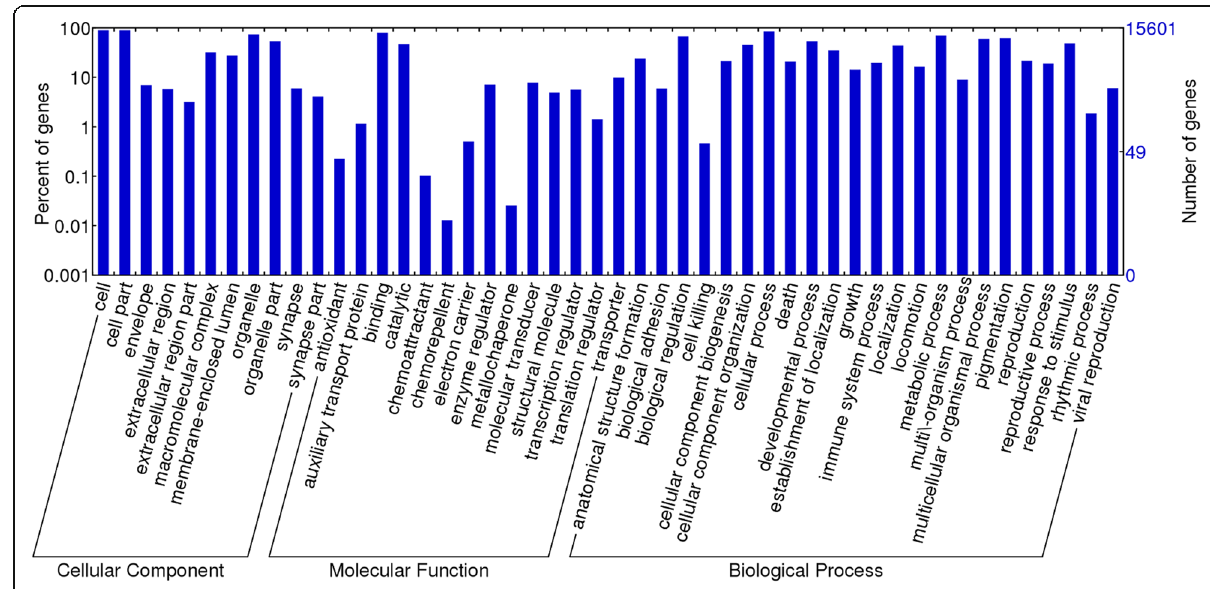
Fig. 5 Category of gene ontology annotation